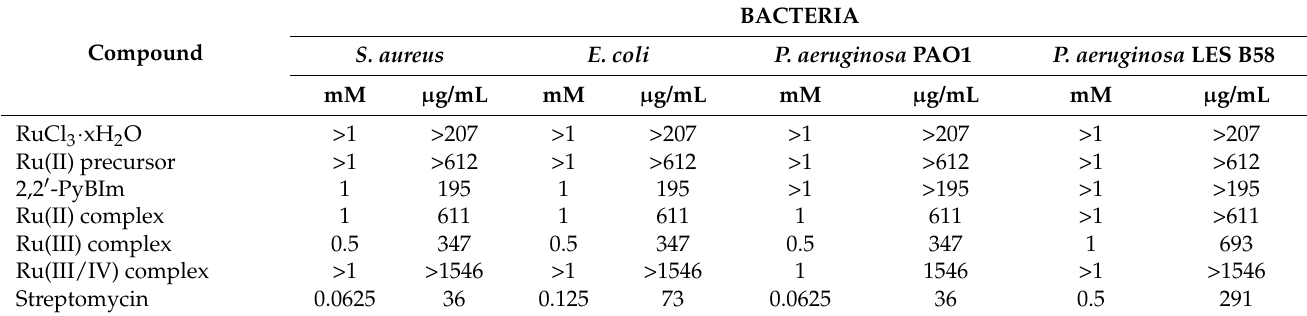
Table 2. Results of the minimum inhibitory concentration (MIC) for the compounds evaluated, expressed in mM and µ g/mL.